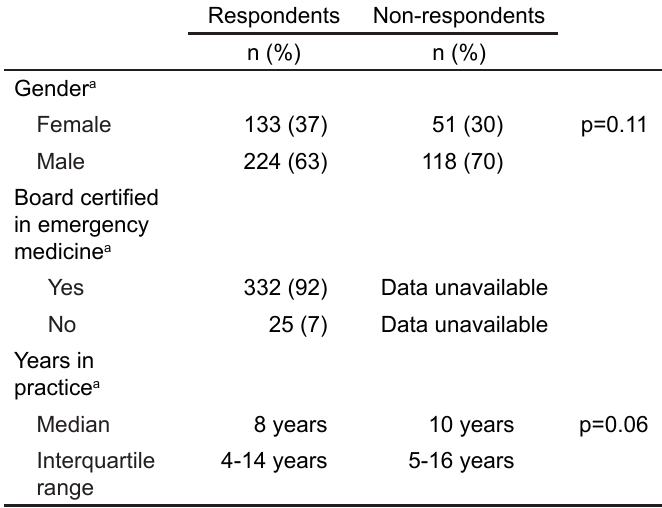
a 9 respondents did not answer this